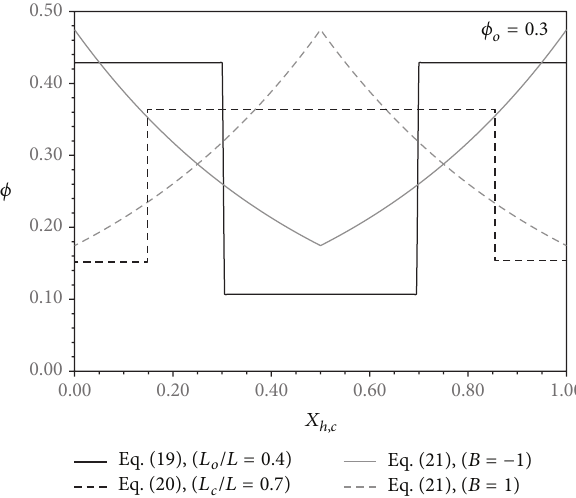
Figure 2: Variation of 𝜙 with 𝑋 ℎ and 𝑋 𝑐 for the step distributions and exponential